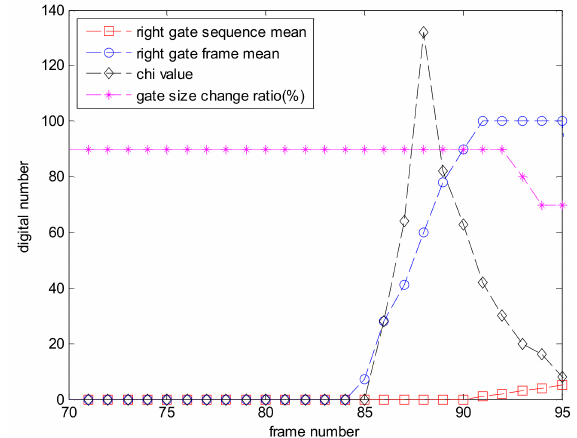
Figure 11. Brightness change histories of the right side gate among four-directional background gates are shown when the target moves in the right direction. χ value (chi) increases as the intensity mean of the frame mean (right gate frame mean) definitely changes compared to intensity mean over the sequence (right gate sequence mean). As the target is being hidden behind an obstacle, gate size became smaller than its average